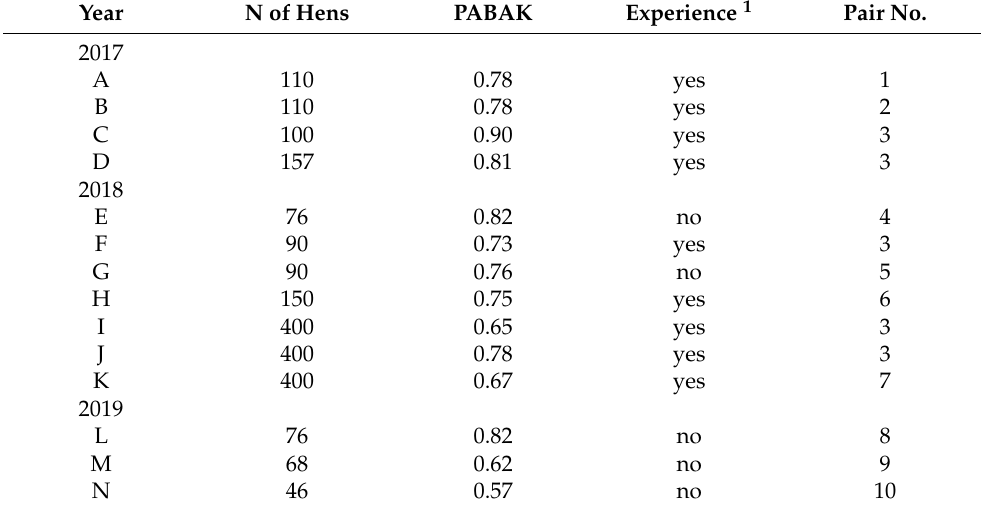
Table 1. Results of inter-assessor reliability tests (prevalence-adjusted, bias-adjusted kappa: PABAK) for the assessment of keel bone damage in laying hen carcasses by visual inspection between ten different pairs of one trained person and an experienced or inexperienced further